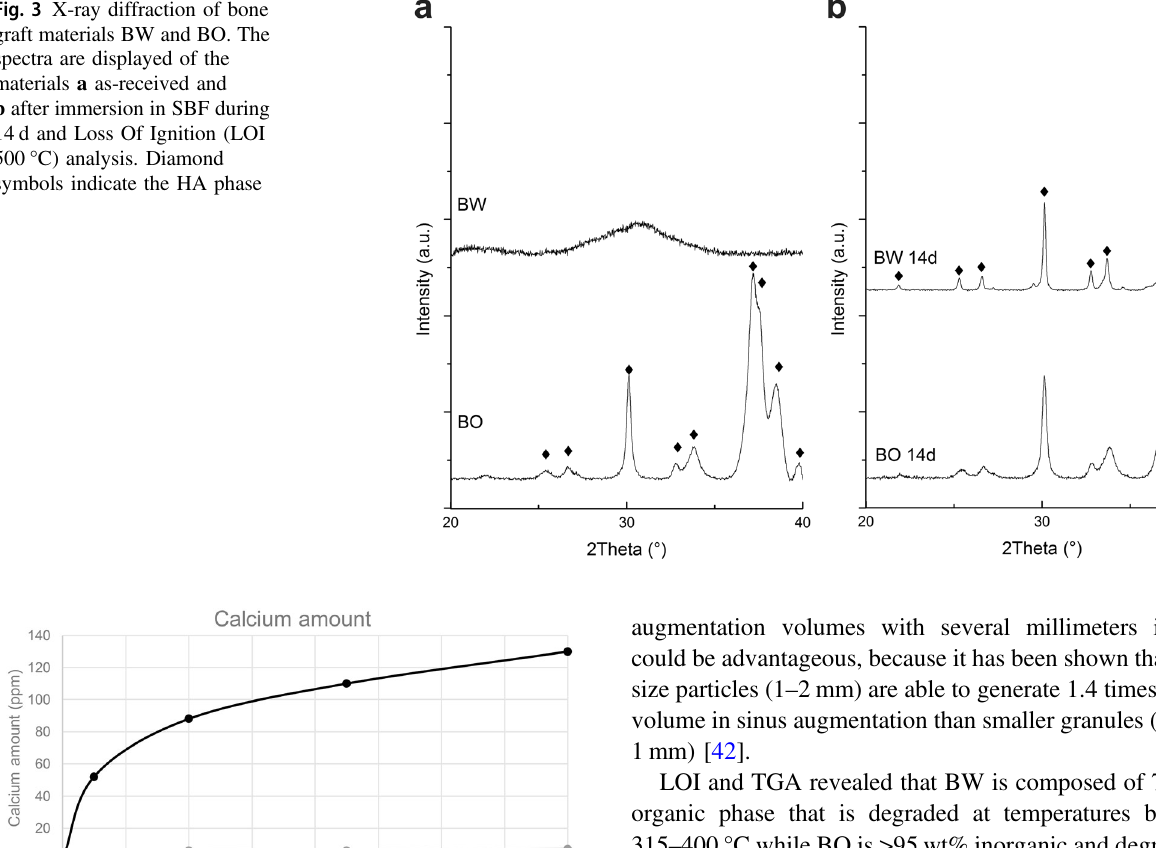
Fig. 3 X-ray diffraction of bone graft materials BW and BO. The spectra are displayed of the materials a as-received and b after immersion in SBF during 14 d and Loss Of Ignition (LOI 500 °C) analysis. Diamond symbols indicate the HA phase